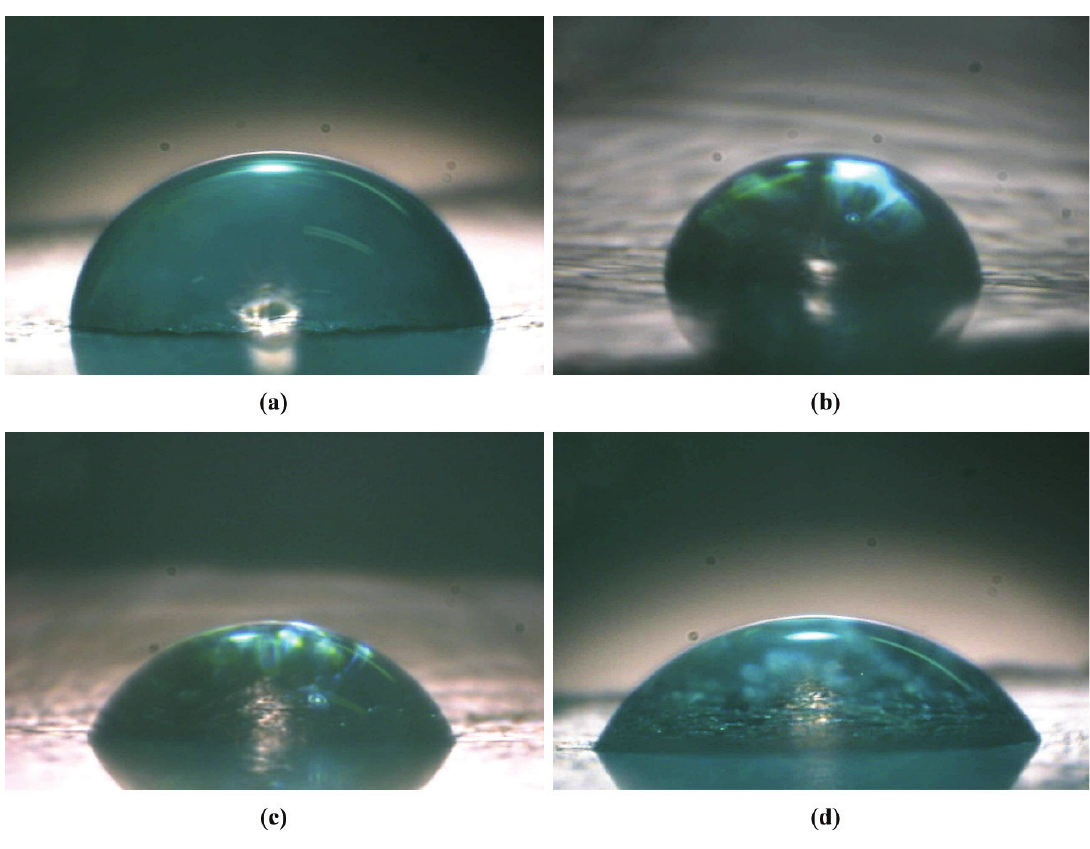
Figure 4. Cross section micrographs obtained by SEM analysis of hybrid films (a) acetic, (b) hydrochloric and (c) nitric acid.